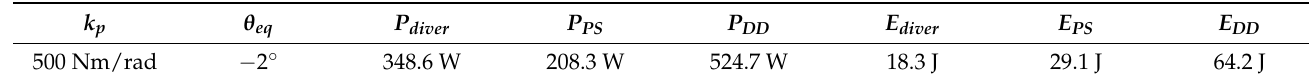
Table 4. Simulation result of the optimization.